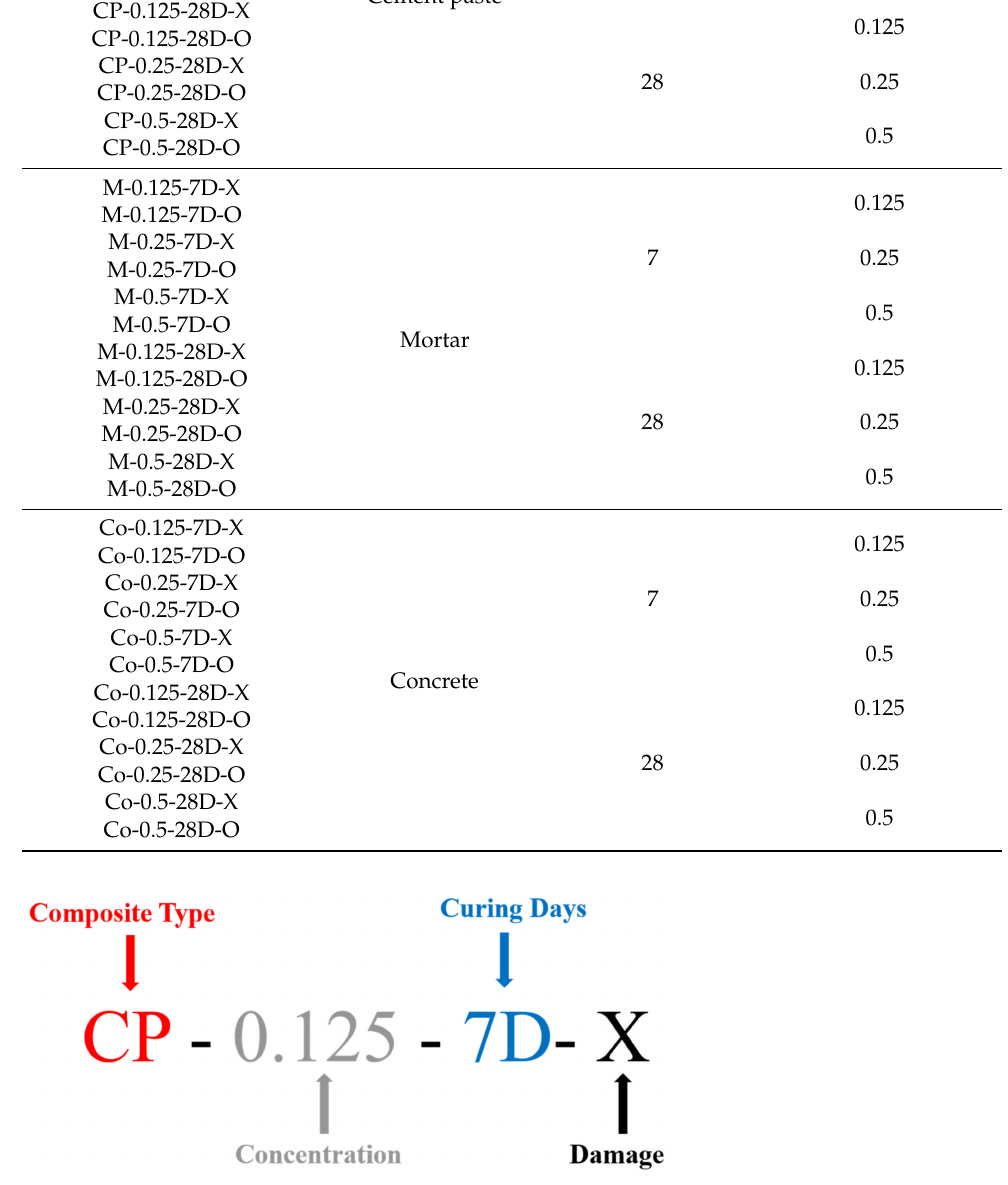
Figure 1. Specimen